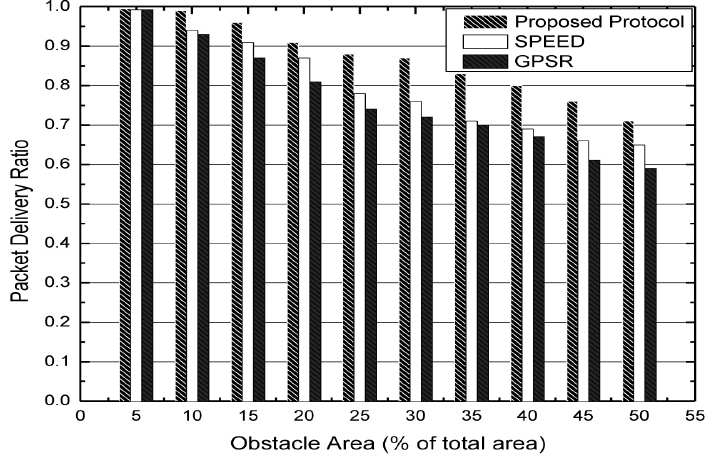
Figure 10. Packet delivery ratio with expanding obstacle